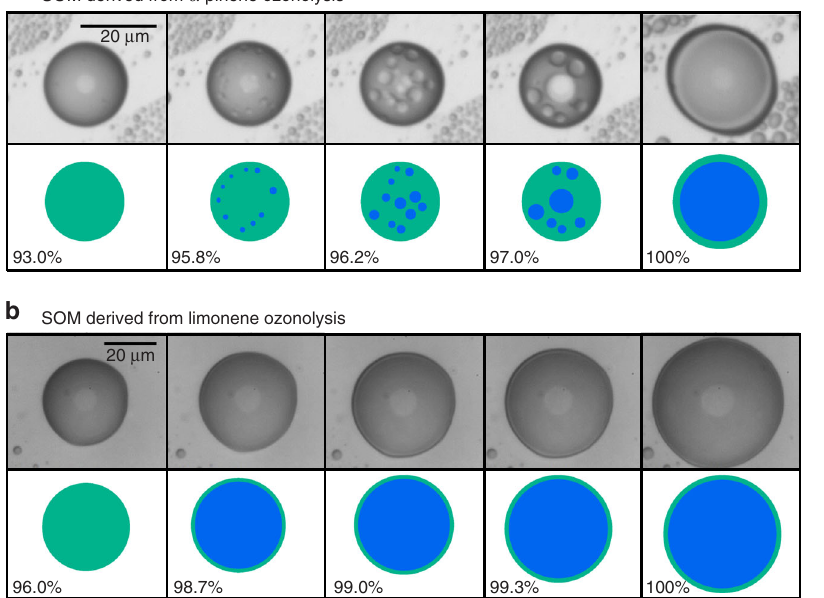
Fig. 2 Optical microscopic images show the presence of LLPS at high relative humidity for supermicron SOM particles derived from α -pinene and limonene ozonolysis. Illustrations of the images are shown for clarity. Images for a α -pinene-derived SOM and b limonene-derived SOM were taken from previous experiments described in ref. 24 and ref. 28 , respectively. Images are shown for an increasing RH. Small inclusions in a show the formation of a second liquid phase. The light gray circles at the center of the particles are an optical effect of the microscope and therefore are excluded from the